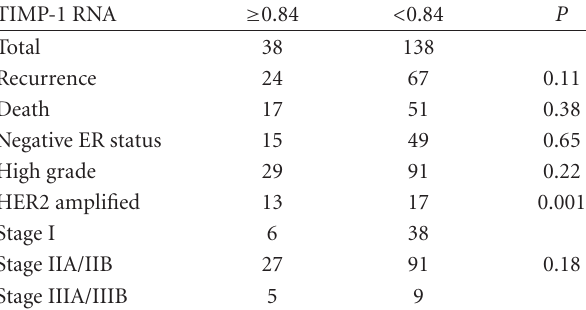
Table 2: Occurrence of clinical/pathological features in patients with relative TIMP-1 RNA levels of ≥ 0.84 ( n = 38) compared to patients with relative TIMP-1 RNA levels of < 0.84 ( n =